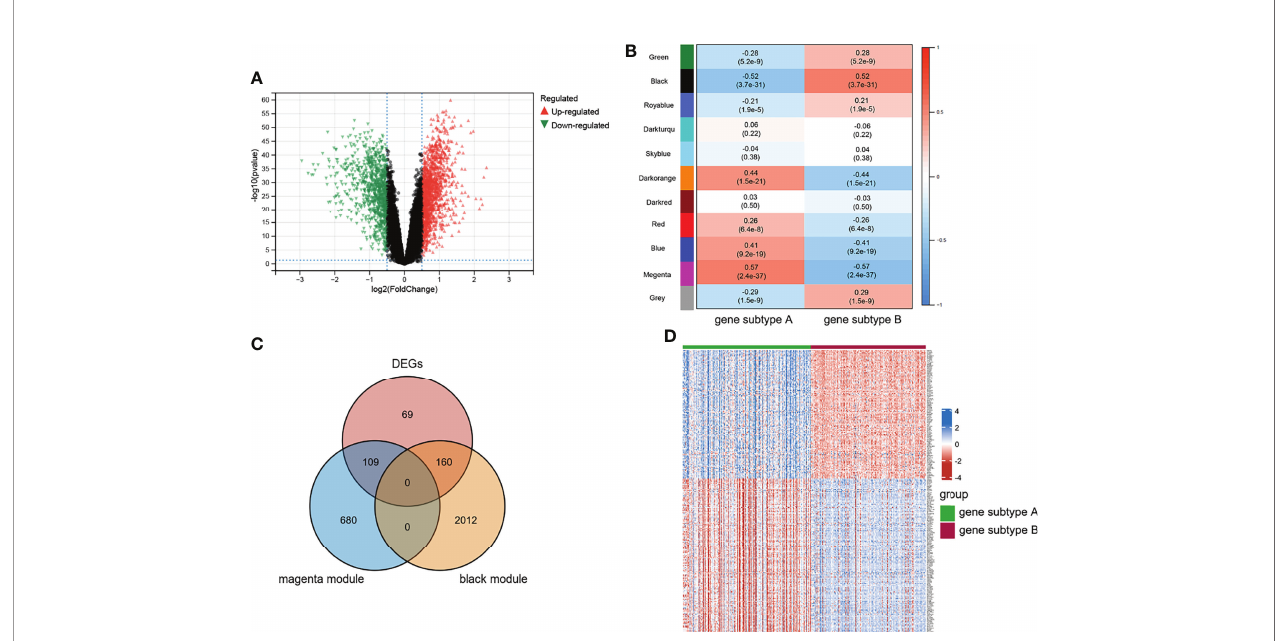
FIGURE 6 | Characteristic of genes subtypes. (A) Volcano plot of DEGs between two genes subtypes. (B) WGCNA module trait relationships in gene subtype A and B, which contained the corresponding correlation and p-value. (C) Intersection of DEGs and subtypes related genes. (D) Heatmap of representative DEGs; blue and red represent upregulated and downregulated expression,